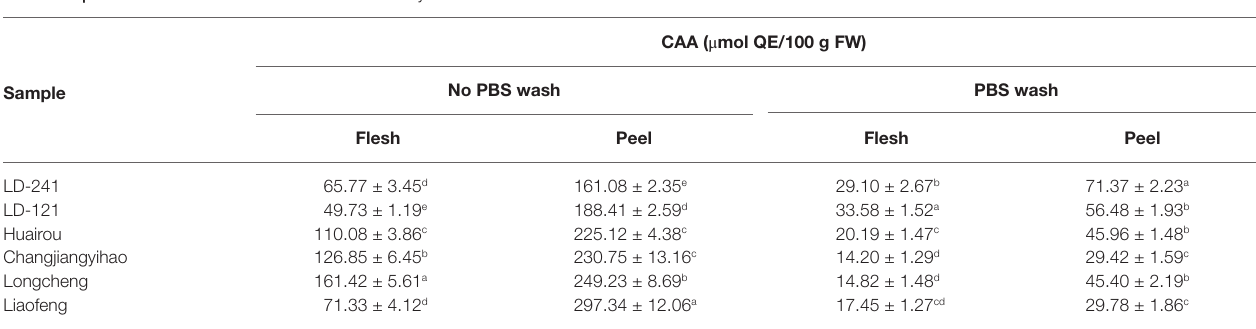
TABLE 4 | Cellular antioxidant activities of six kiwi berry varieties a